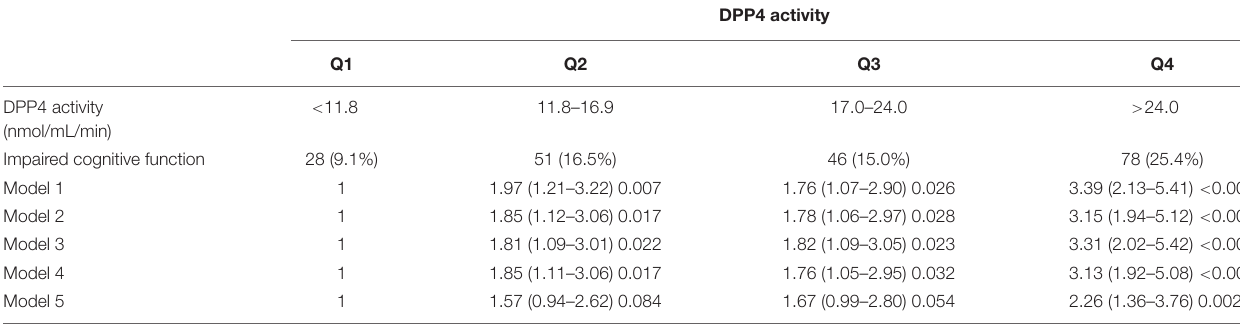
TABLE 5 | Logistic regression analysis of the association of DPP4 activity and impaired cognitive